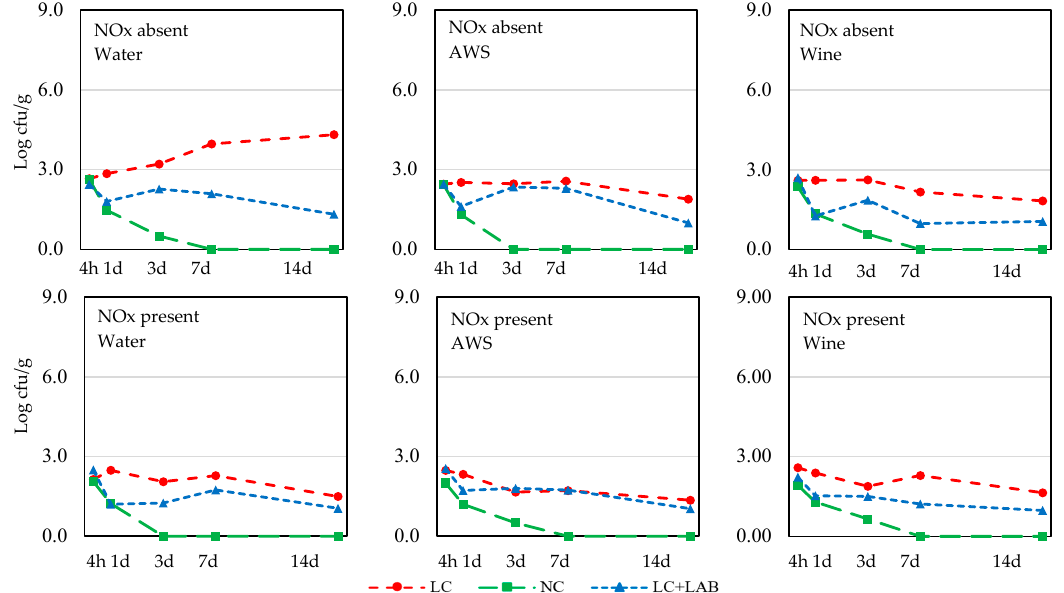
Figure 3. Behavior of S. aureus during incubation of chouriço batter made from low contaminated meat ( LC ), normal contaminated meat ( NC ), and low contaminated meat with LAB added ( LC + LAB ), with or without nitrite plus nitrate ( NOx ) and water, artificial wine solution ( AWS ), or wine ( n = 4).